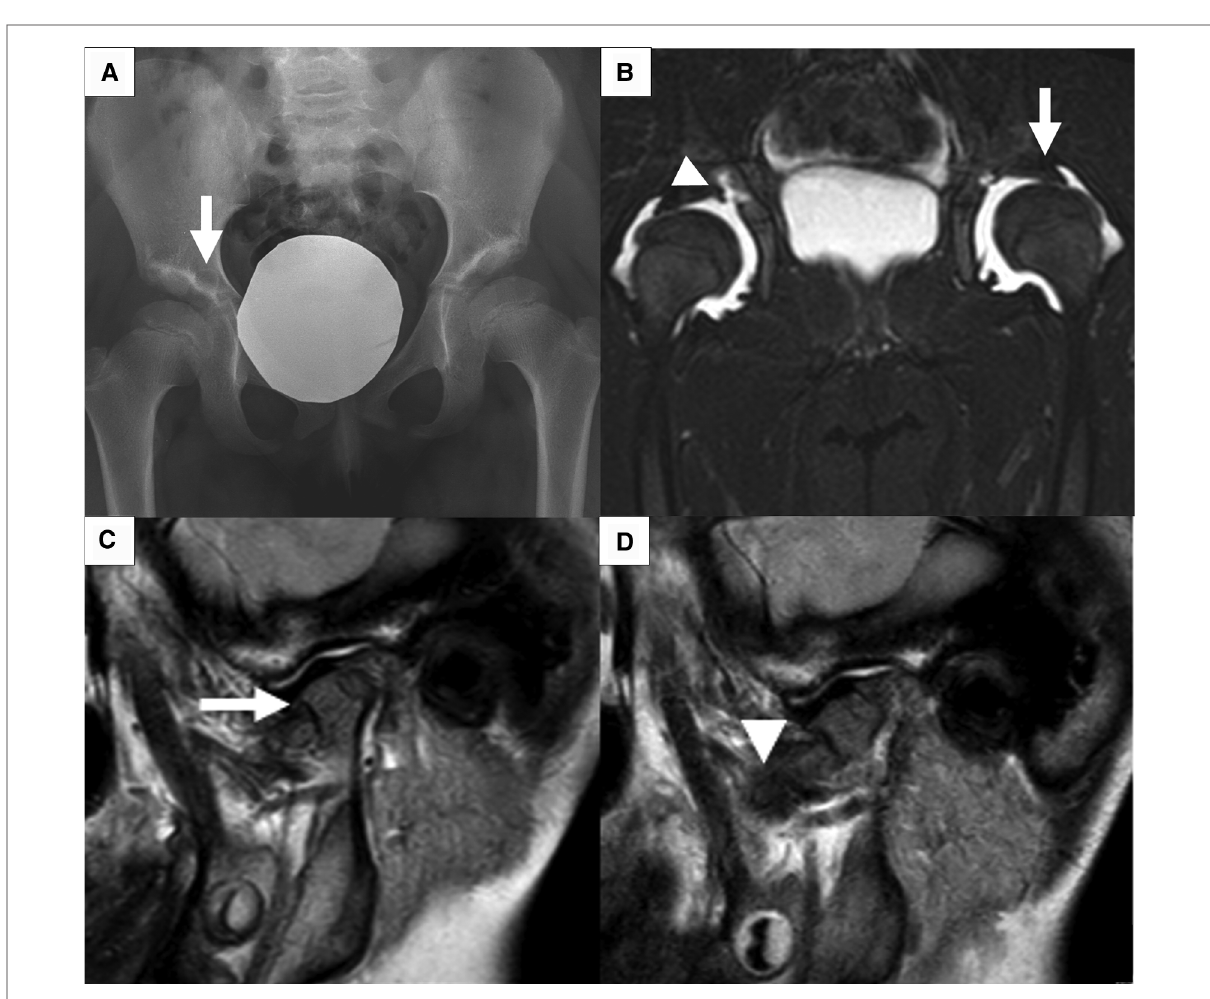
FIGURE 1 Main radiological feature. ( A ) X-ray of the pelvis shows fl attening of femoral heads, stubby and short femoral neck, and bilateral coxa vara. Acetabular roofs are irregular with sclerotic surfaces and radiolucent lytic areola ( arrow ) as per acetabular cyst. ( B ) Short tau inversion recovery sequence of pelvis MRI shows effusion at coxofemoral joints resulting in partial femoral head dislocation ( arrow ); acetabular cyst connected with joint effusion ( arrowhead ). ( C, D ) MRI of left TMJ in close and open mouth shows little/no excursion of the condyle. The condyle has an enlarged and fl attened morphology ( arrow ) with irregular surface. A slim layer of intra-articular effusion is present. The articular disc ( arrowhead ) has normal morphology and